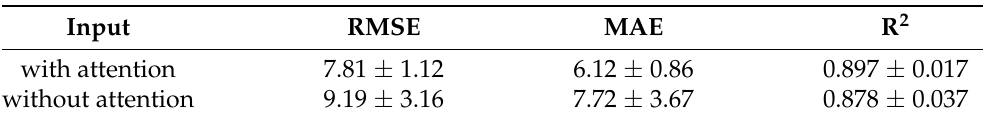
Figure 13. Comparison between predicted (EST) and ground truths (REF) in HR estimation: ( a ) is the best case; and ( b ) is the worst case. Table 7. Mean and standard deviation of RMSE, MAE, and R 2 values of models with (proposed model) and without the attention for HR estimation.